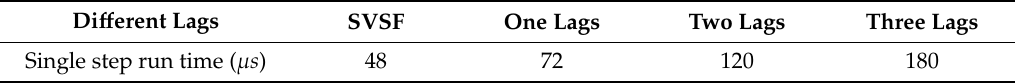
Table A2. Implementation Times of SVSS under di ff erent lag fixed